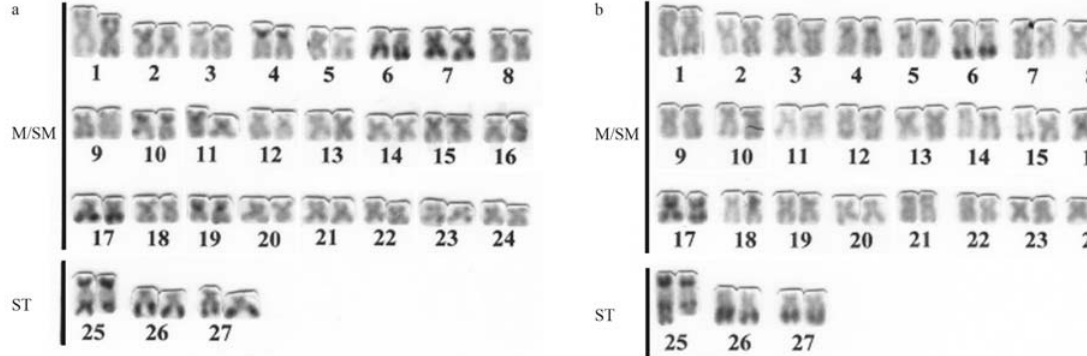
Figure 2 - C-banded karyotypes of: a. Parodon tortuosus and b. Parodon nasus .